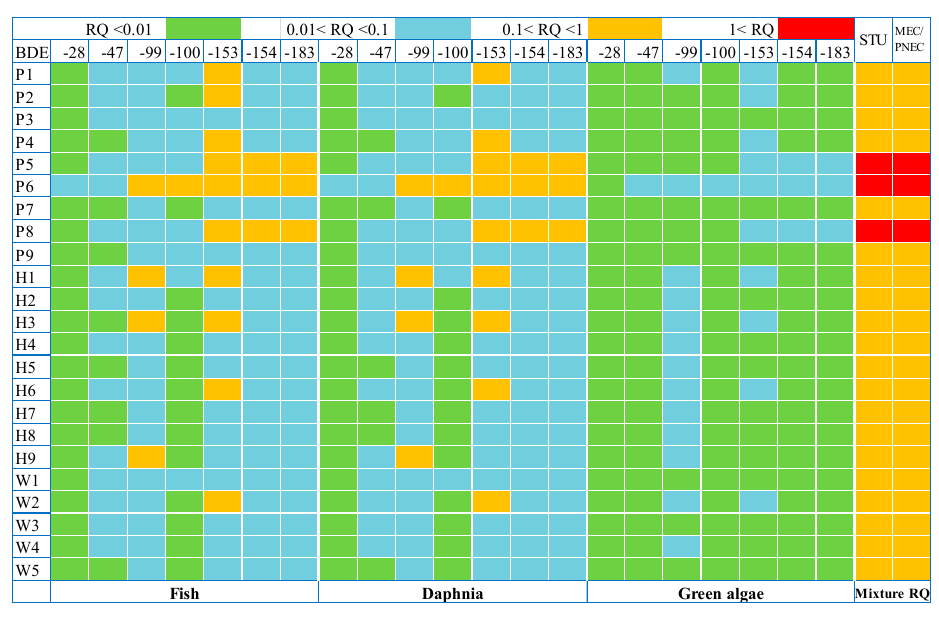
Figure 6. Risk quotients (RQs) of PBDEs for green algae, daphnia, and fish in water from the Chaohu Lake basin.